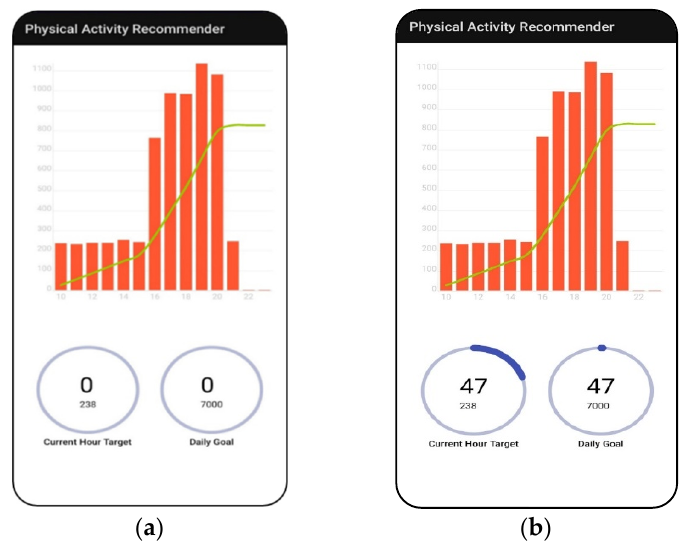
Figure 12. ( a ) Recommended activity pattern; ( b ) step count progress tracker.